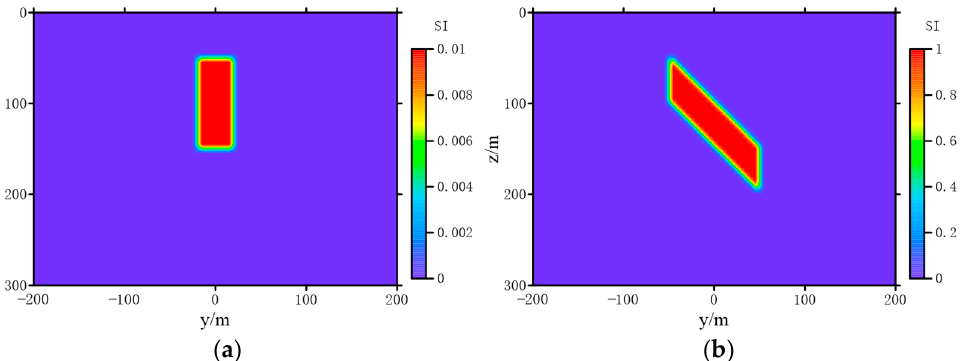
Figure 4. The tested models used for studying the effect of smooth vector strategy. ( a ) Model 1, ( b ) Model 2. Figure 5 is the magnetic anomaly curve when the magnetic susceptibility χ was